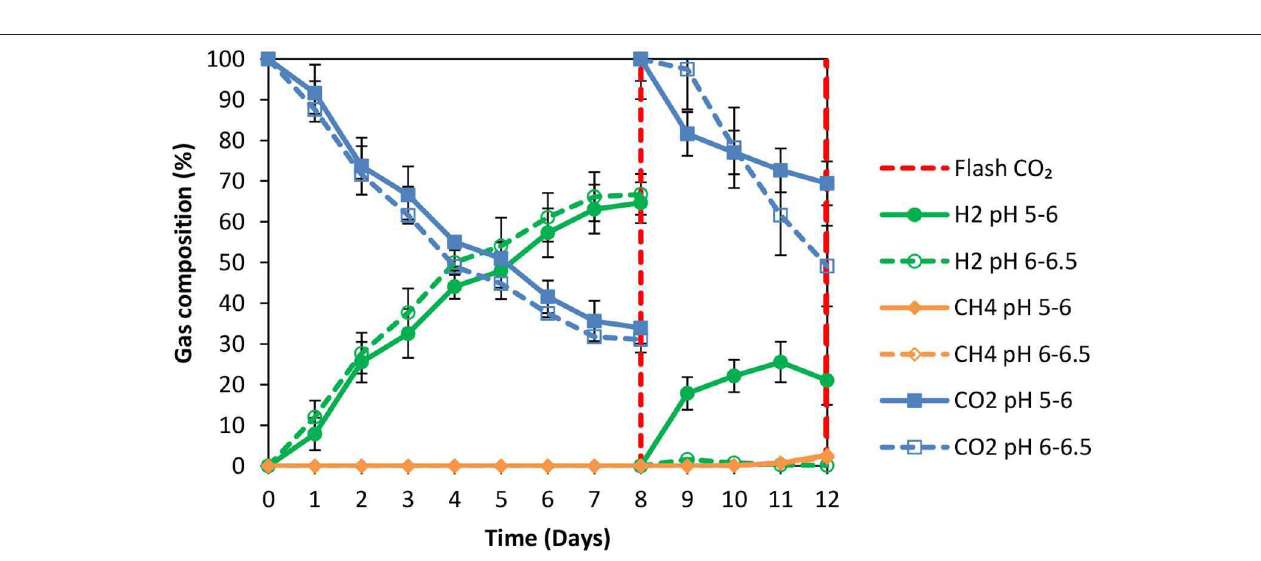
FIGURE 3 | Gas composition over time for anaerobic granular sludge that was pre-heated and then exposed to 100 g/L ZVI and operated at pH 5–6 and pH 6–6.5,